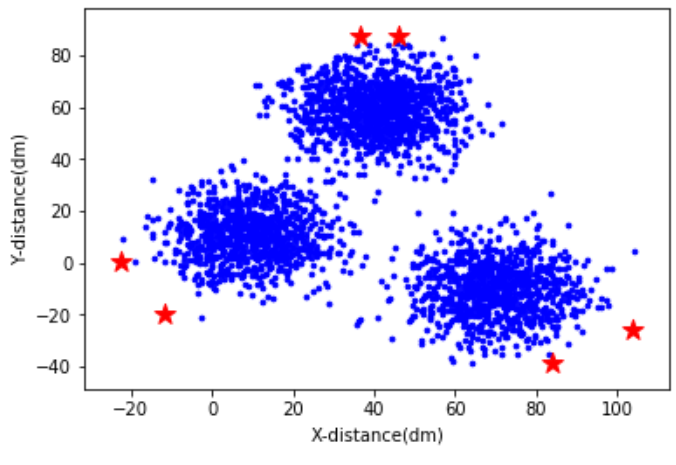
Figure 3. Distribution of original data sets. Electronics 2019 , 8 , x FOR PEER REVIEW